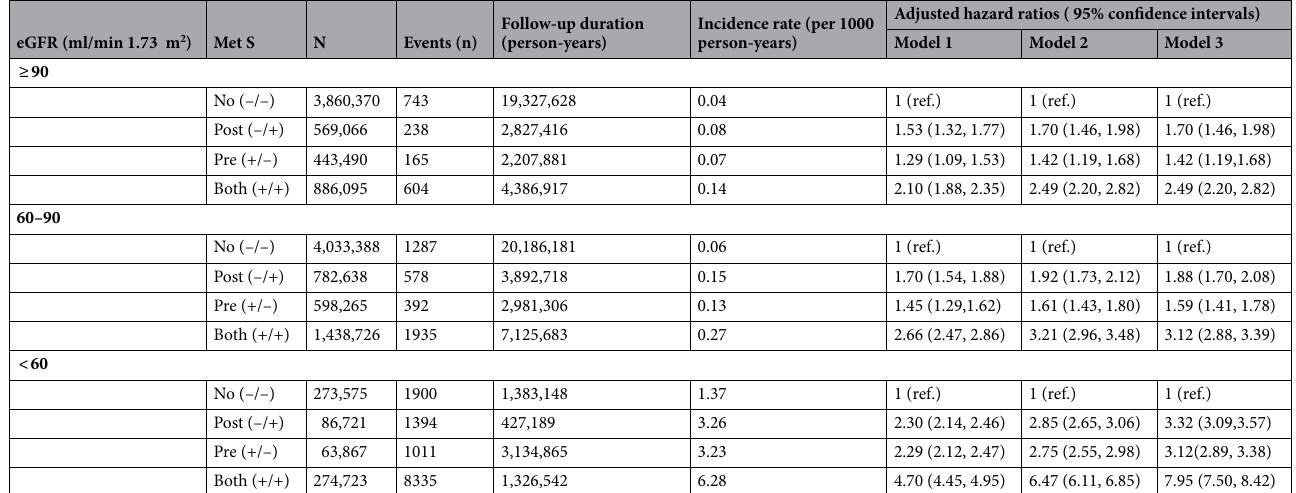
Table 4. Adjusted hazard ratios, 95% confidence intervals, and incidence rates of end-stage renal disease development according to the change of MetS component in different renal function groups. Model 1, adjusted for No. of MetS components at 1st visit, age and sex; Model 2, Model 1 plus adjusted for smoking, drinking and exercise; Model 3, Model 2 plus adjusted for estimated GFR.